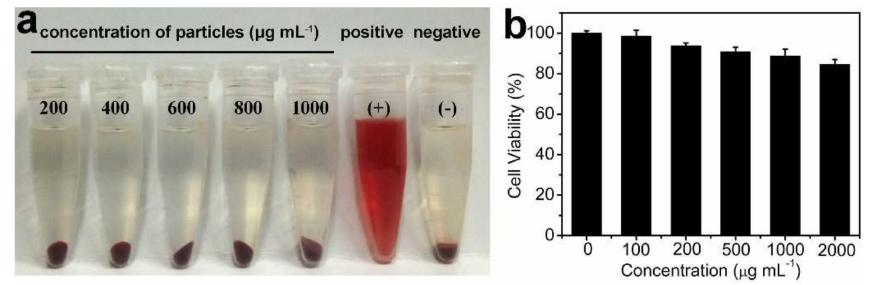
Figure 11. Photographs of RBCs after incubation with varied concentrations of MSNs-S-S-DMSA for 24 h ( a ). RBCs samples treated with deionized water and DPBS were used as the positive and the negative control, respectively. Viability of HL-7702 cells after incubation with varied concentrations of MSNs-SS-DMSA for 24 h ( b